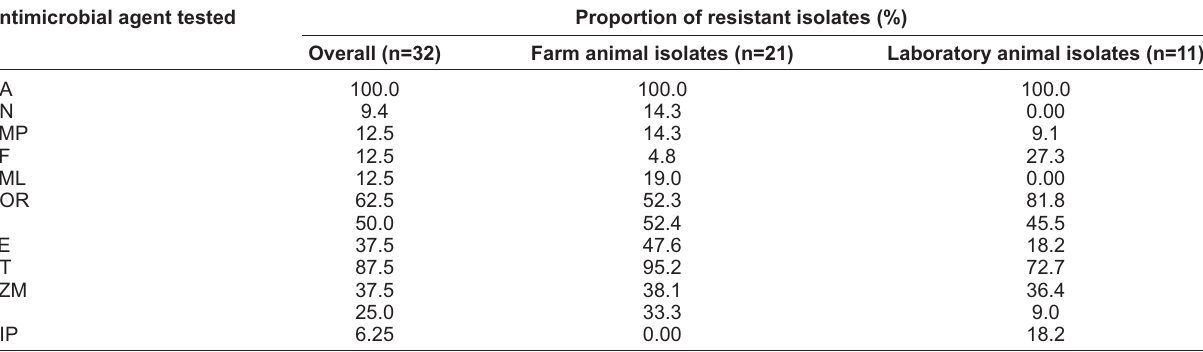
Table-1: Antimicrobial resistance profiles of isolates derived from laboratory and farm animals (general) Campylobacter Antimicrobial agent tested Proportion of resistant isolates (%)